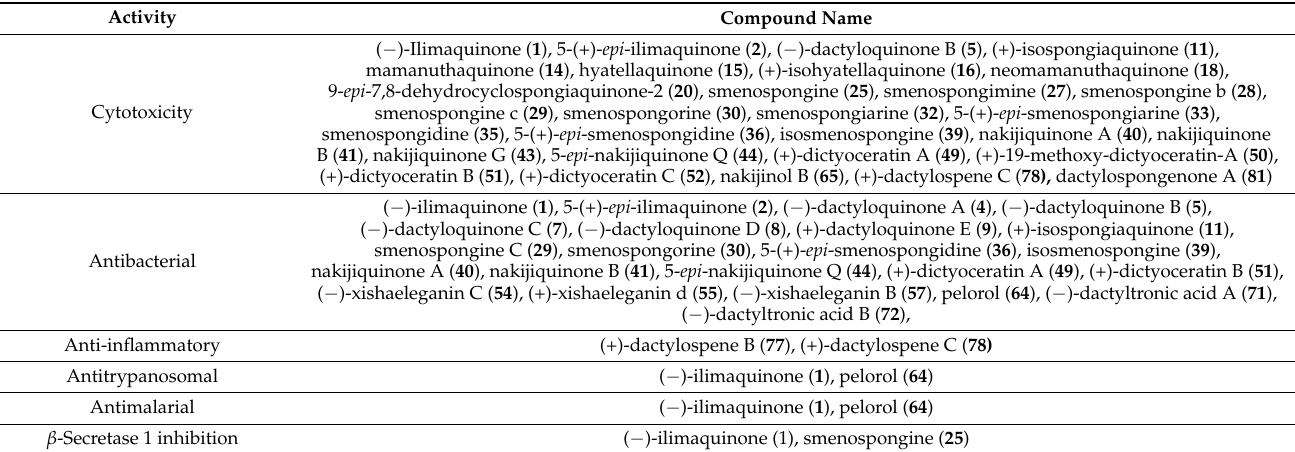
Figure 2. Chemical structures of compounds 1 – 24 . Table 1. Reported promising bio-activities of Dactylospongia elegans sesquiterpenes